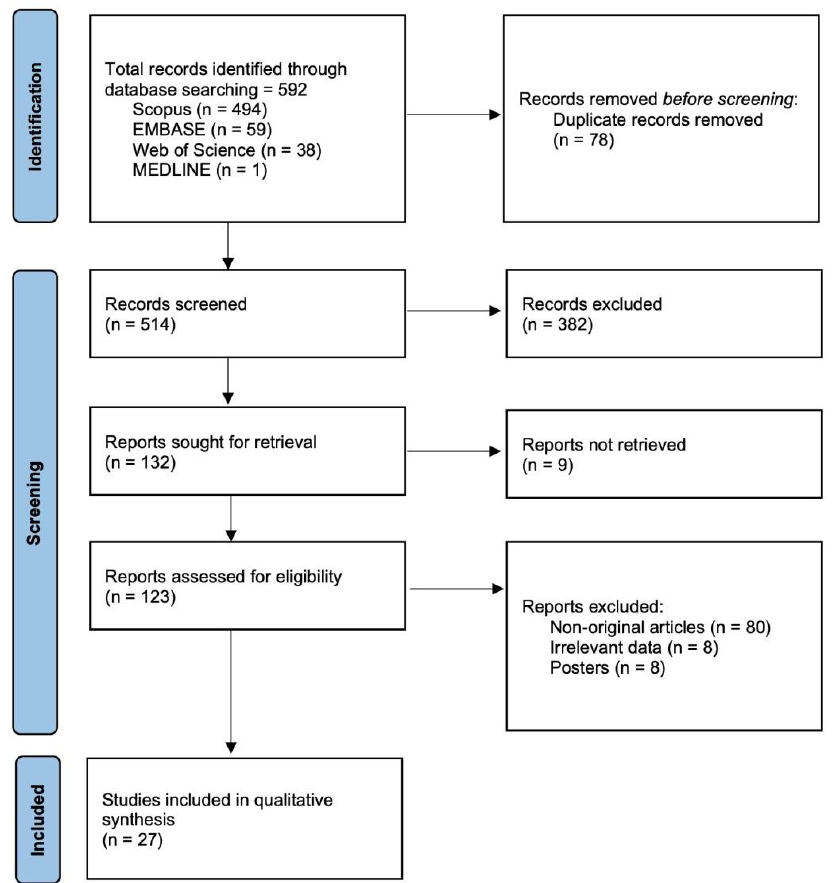
Figure 1. PRISMA flow diagram for selection of articles reporting data of in vitro antifungal suscepti- bility and therapeutic efficacy evaluation of investigational antifungals tested against Candida auris up to 27 June 2022.